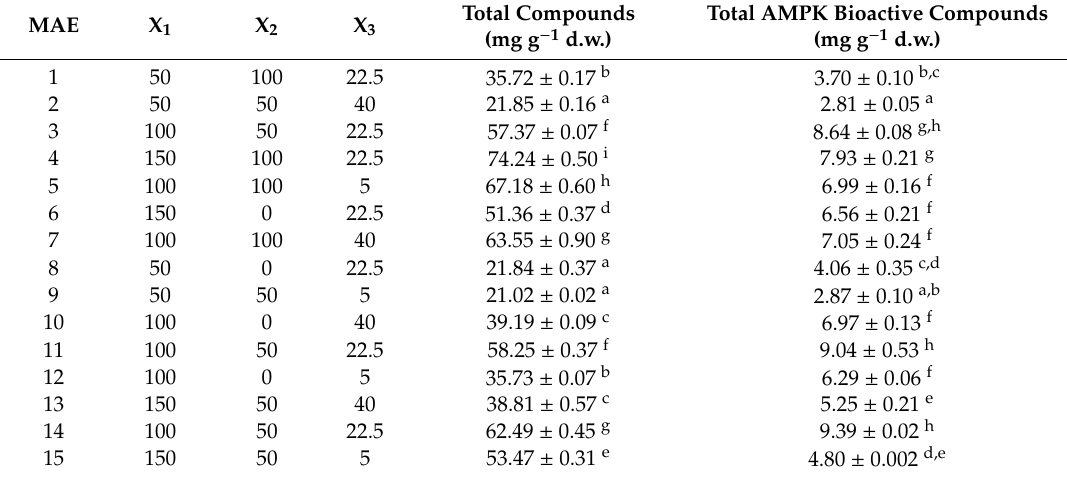
Concentration of total compounds and total AMP-activated protein kinase (AMPK) bioactive compounds in olive leaf extracts from microwave-assisted extraction (MAE) obtained by Box Behnken design.